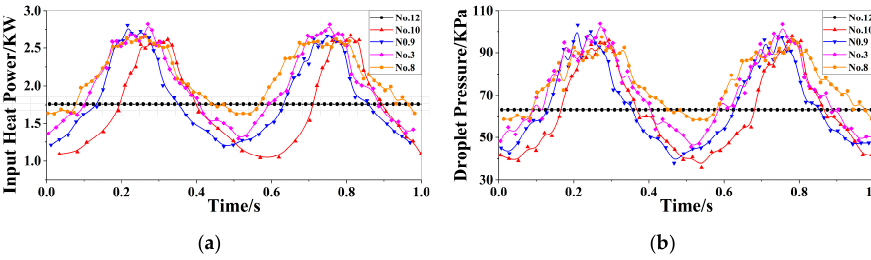
Figure 11. Changes of heat input ( a ) and droplet impingement force ( b ) in thermal pulse of DP-GMAW. Table 3. Heat input rate (KJ/m) and the thermal gradient of weld pool (K × mm − 1 ) with different parameters.